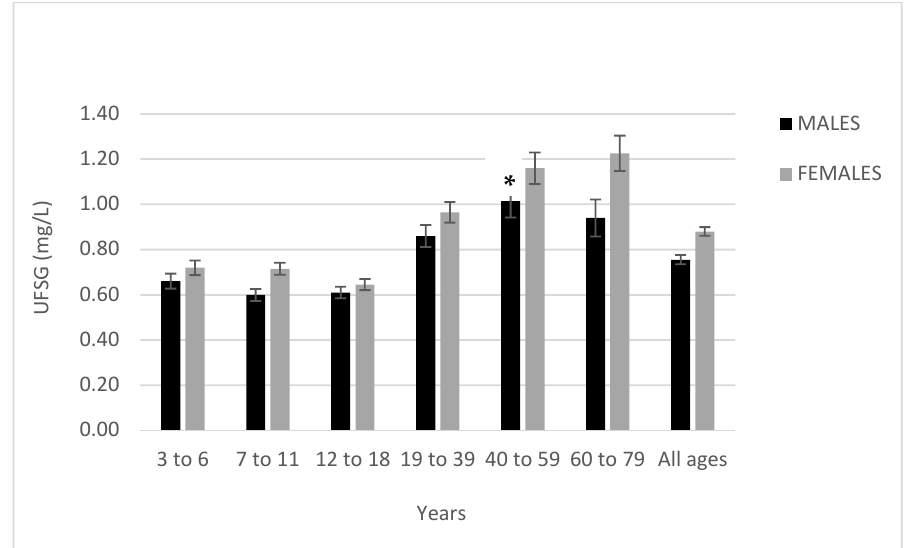
Figure 3. Mean UF SG levels by age group and sex. Error bars represent the standard error of the mean. * Depicts significant difference between males and females ( p < 0.05).